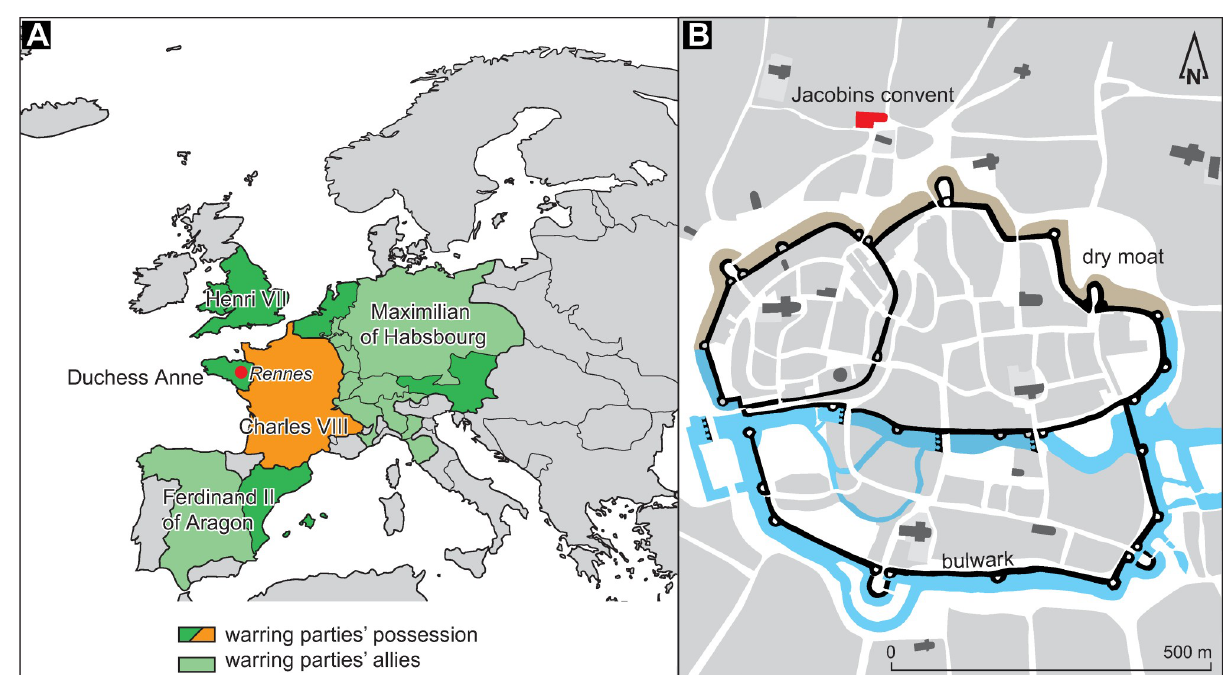
Fig 1. Location of the site. A . Situation in Europe in 1491 and the warring parties involved; B . Location of the Jacobins convent outside the walls of the city of